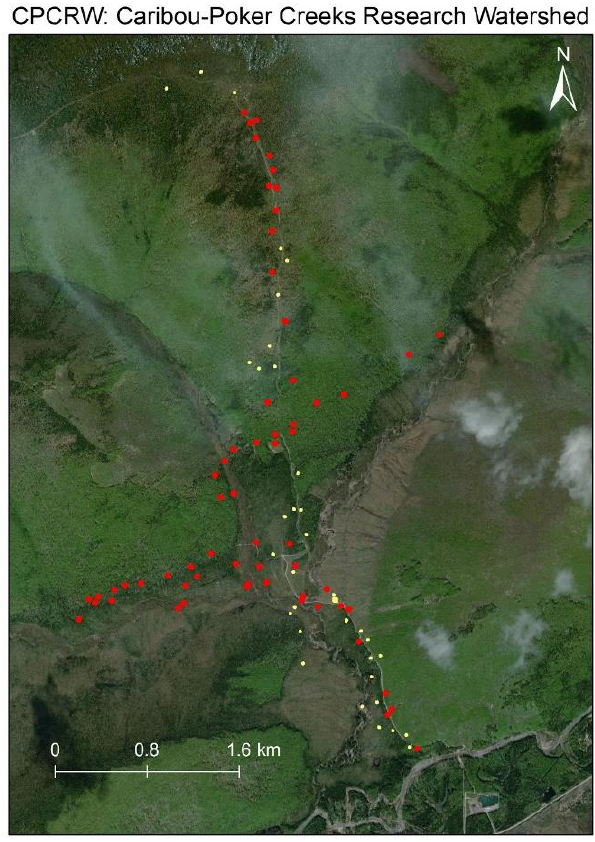
Figure 5 . Map showing the 36 surveyed field plots (yellow) and 62 field locations (red) at CPCRW.